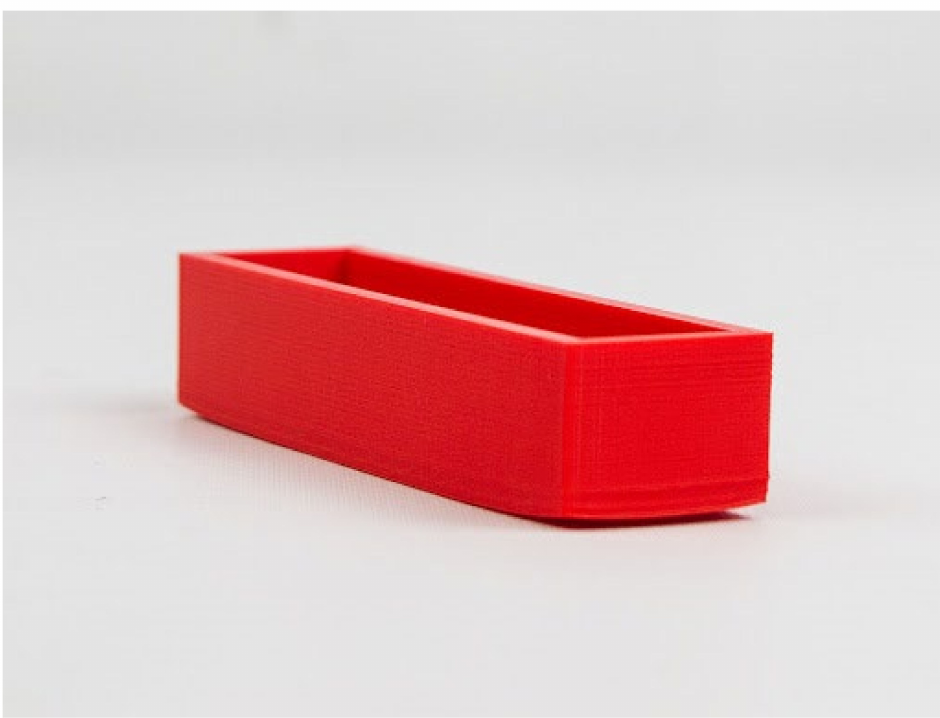
Figure 3. 3D-printed item suffering from shape distortion (lifted corners) caused thermally induced residual